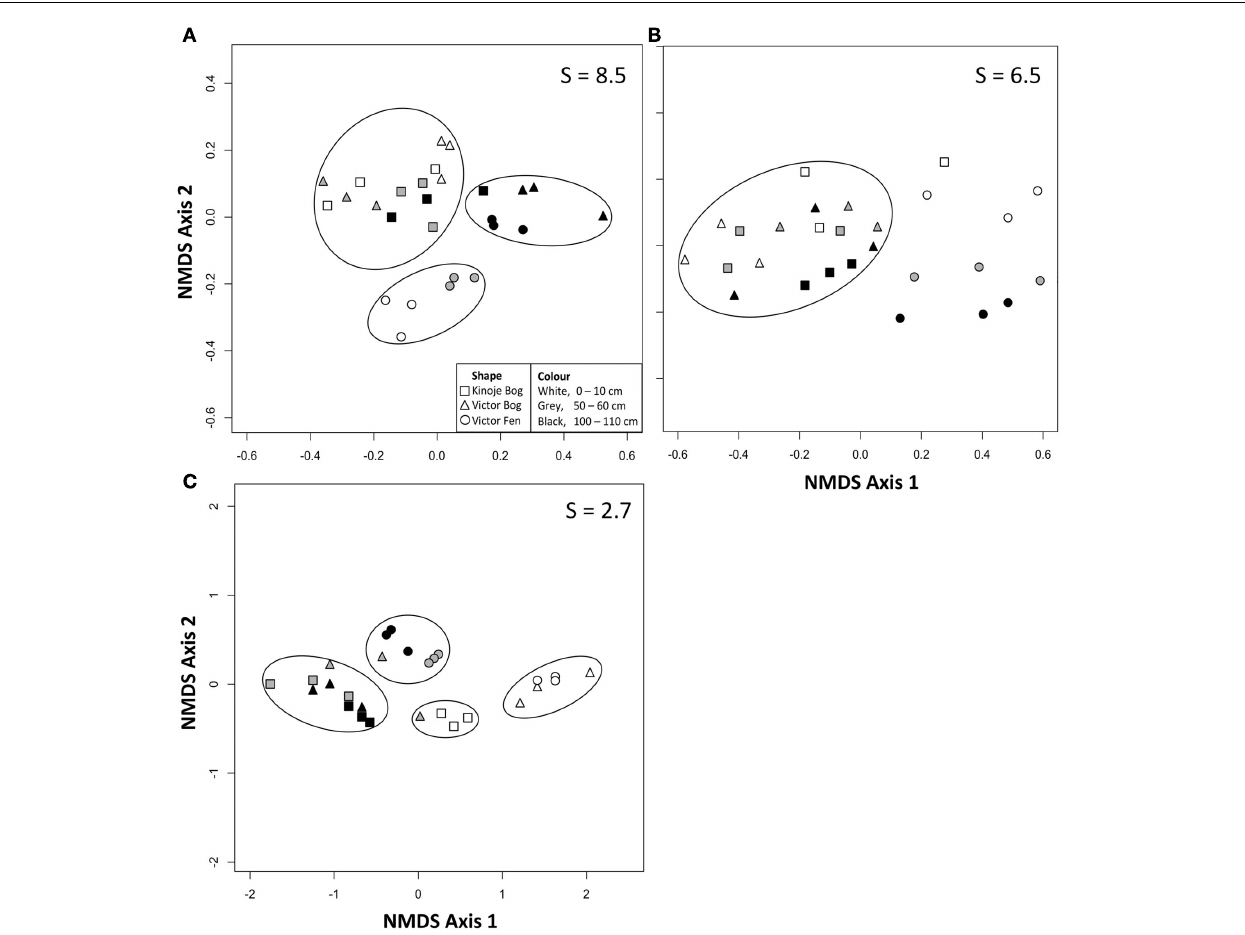
initial extracellular enzyme activity (EEA) from three peat cores collected from the James Bay Lowlands. S indicates the stress value as a percentage and the circles grouping data are guides